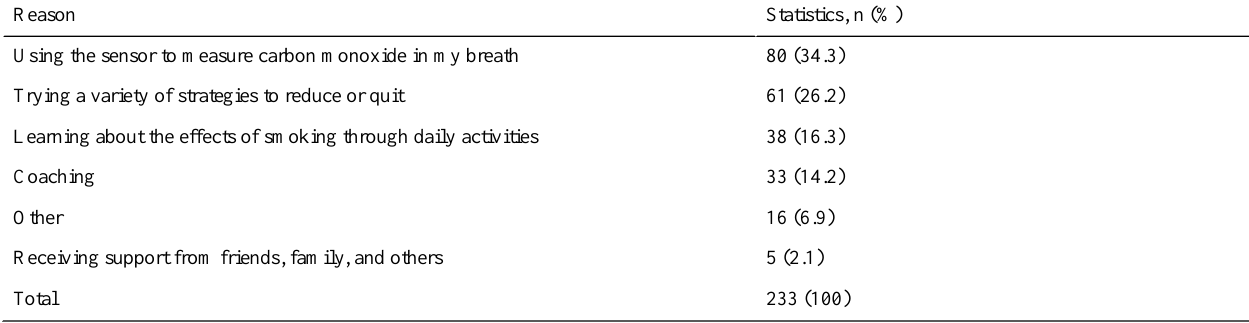
Table 8. Among participants with increased motivation to stop smoking in Pivot, what was the top